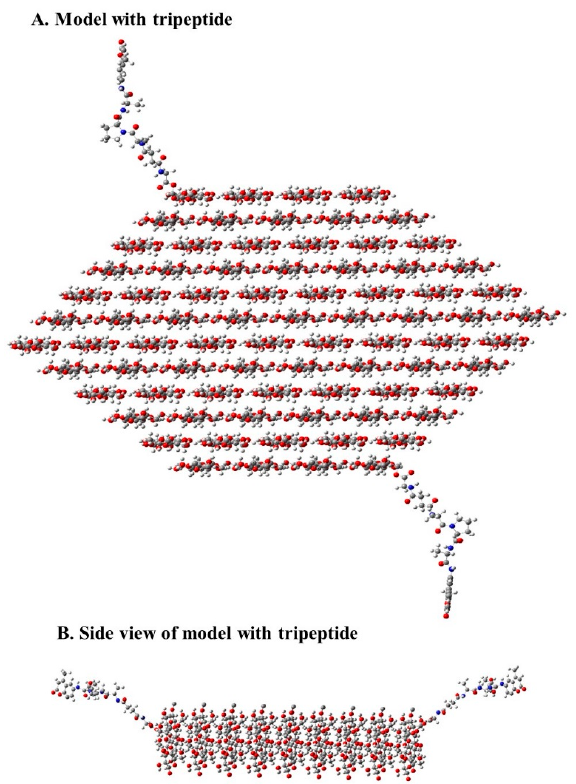
Figure 6. Models of pNA on the X-ray diffraction patterns and Rietveld calculated pattern. The pNA peptide model ( A ) Peptide-cellulose conjugate of aerogel sensor modeled in a single crystal structure with a width of 58.5 Å (78 chains and 12 layers). The side view ( B ) is an image of the same model as in A, but along the longer perimeter of the model.